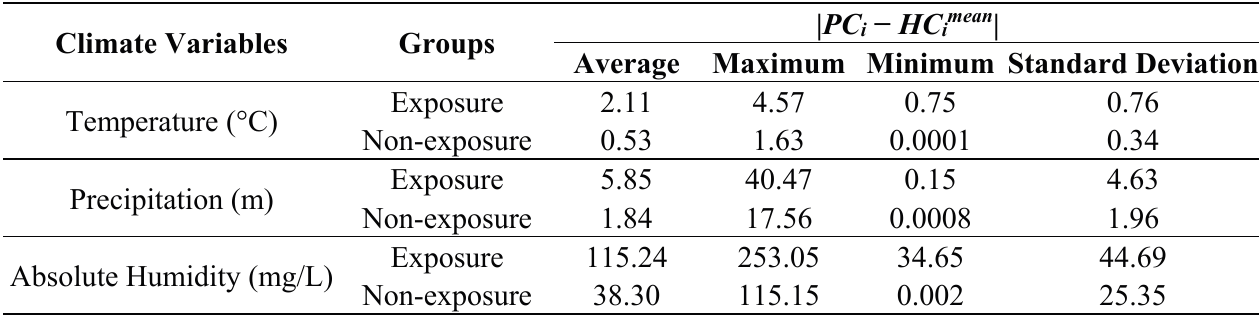
Table 2. Descriptive statistics for the climate variables in the exposure and non-exposure groups in Anhui